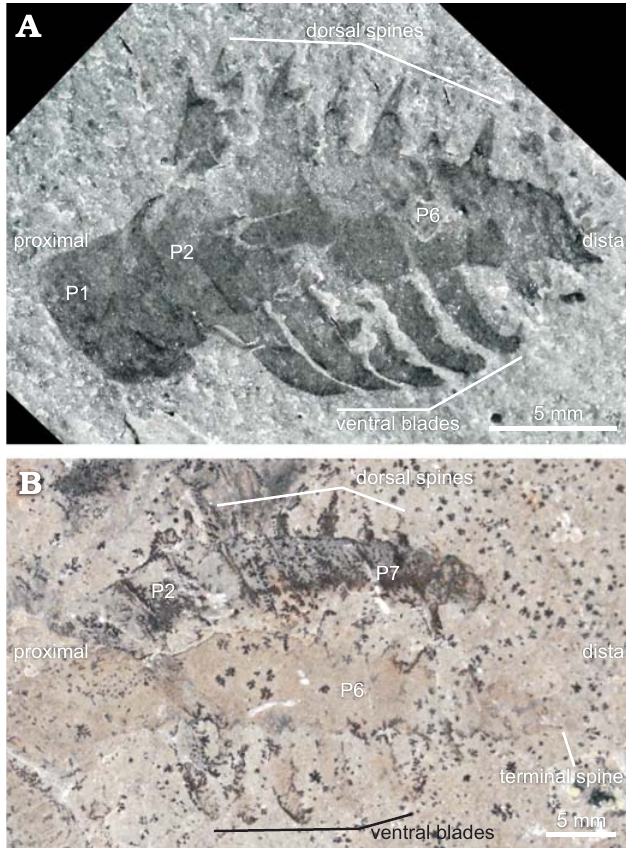
Fig. 5. Radiodontan euarthropod Stanleycaris hirpex Caron, Gaines, Mángano, Streng, and Daley, 2010 from the Stephen Formation (Cambrian Series 3, Stage 5), British Columbia, Canada. A . ROM 59975 (paratype). B . ROM 59976 (paratype). Abbreviation: Pn, podomere